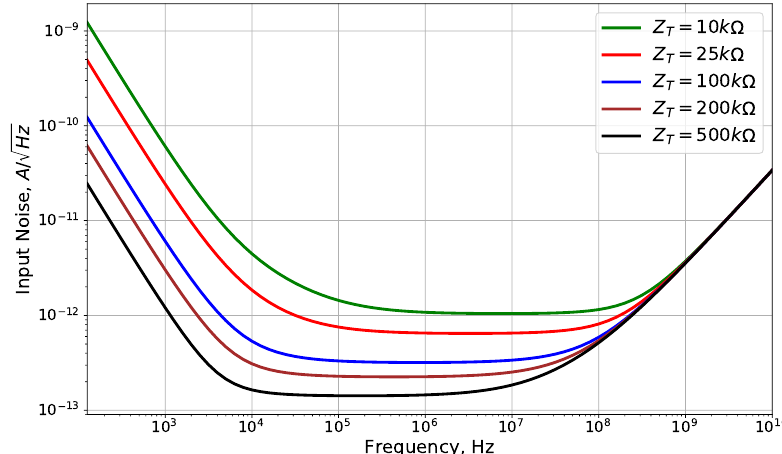
Figure 8. Analytically calculated complete input-referred noise performance for programmable-gain configuration (example case for TSMC 0.18 µ m